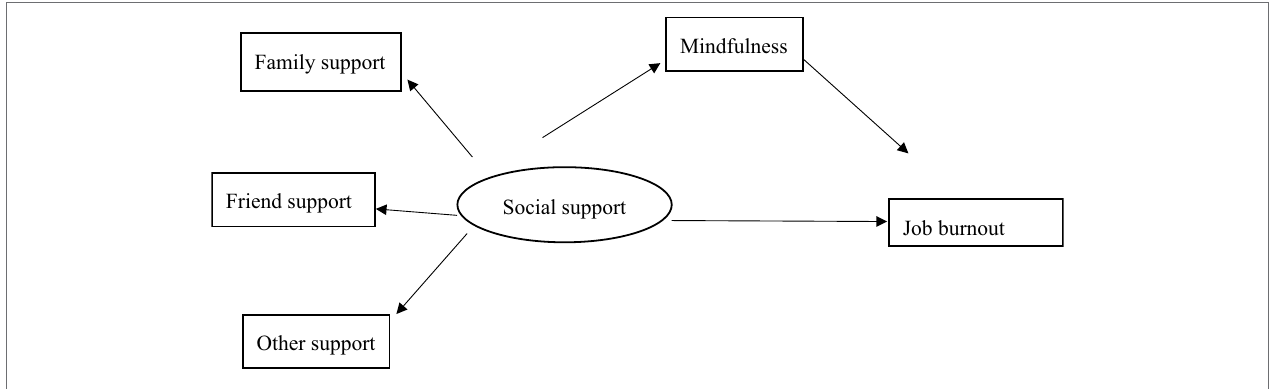
FIGURE 1 | Relational model of social support, mindfulness, and job